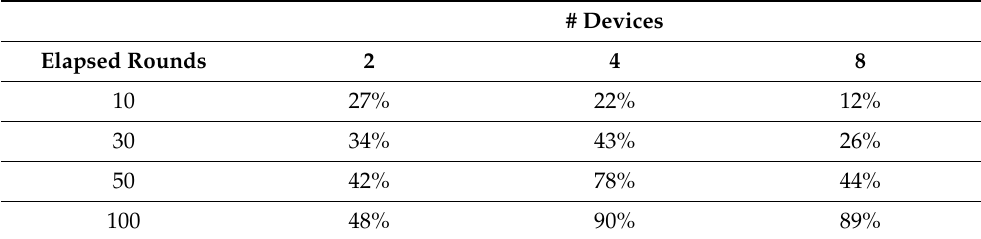
Table 3. Average accuracy for nonuniformly distributed datasets with 2 devices (one with 50% of CIFAR10 images and another with 0.0002%), 4 devices (15%, 25%, 60%, and 0.0002% of CIFAR10 images) and 8 devices (two clients with 7.5%, two with 12.5%, two with 30%, and two with 0.0002% of CIFAR10